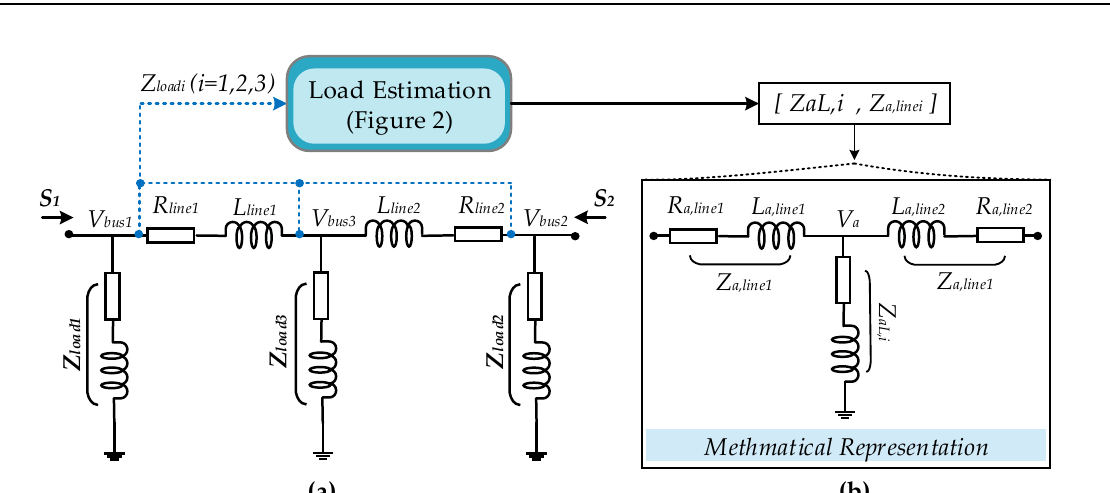
Figure 3. Proposed load estimation scheme. ( a ) Each load-bus impedance is estimated through local load node agents. ( b ) Representation of approximated grid impedance in term of 1 load-bus configuration.